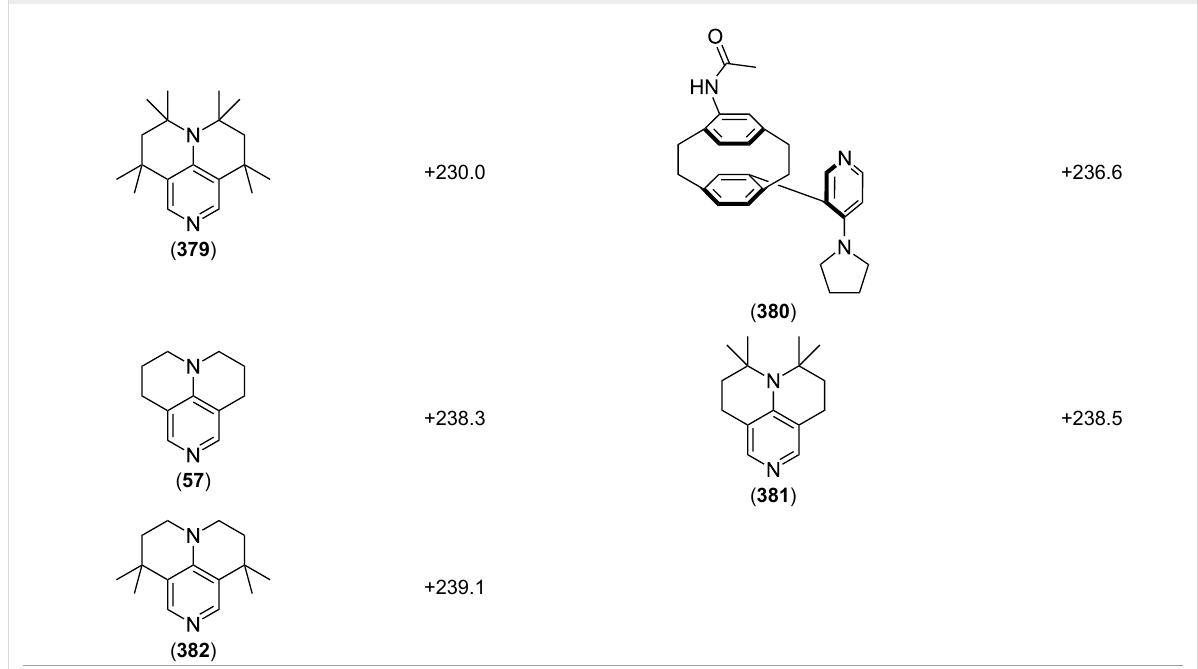
3,4-Diaminopyridines have been shown to be particularly effec- tive as acyl transfer catalysts. This is also visible in the respec- tive ACA values (Table